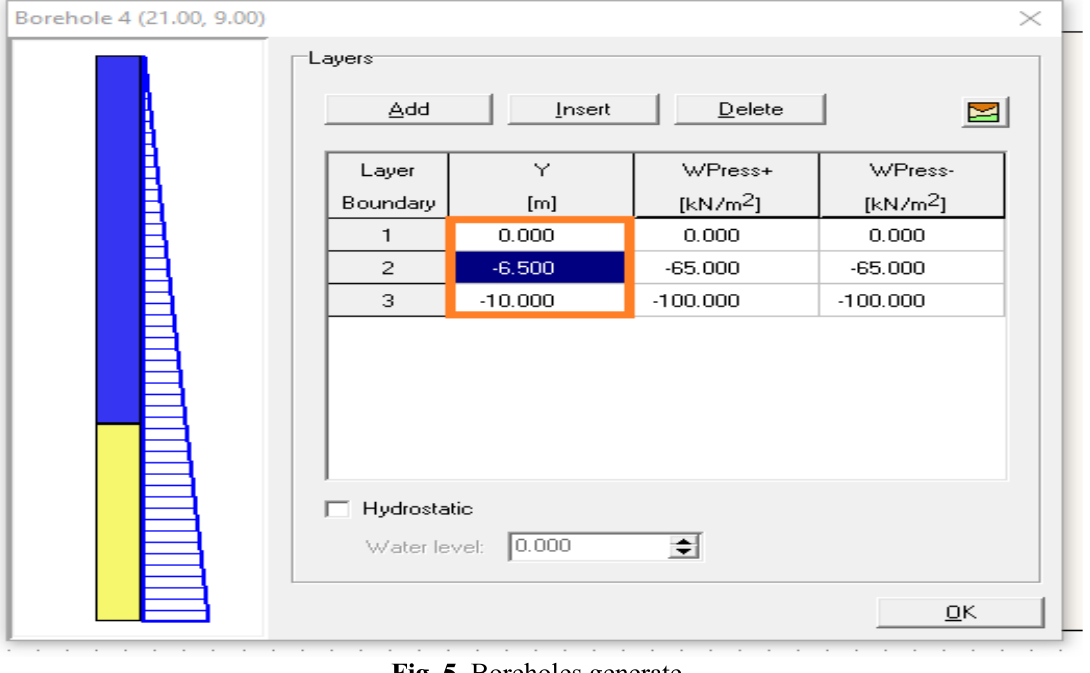
Fig. 5. Boreholes generate.